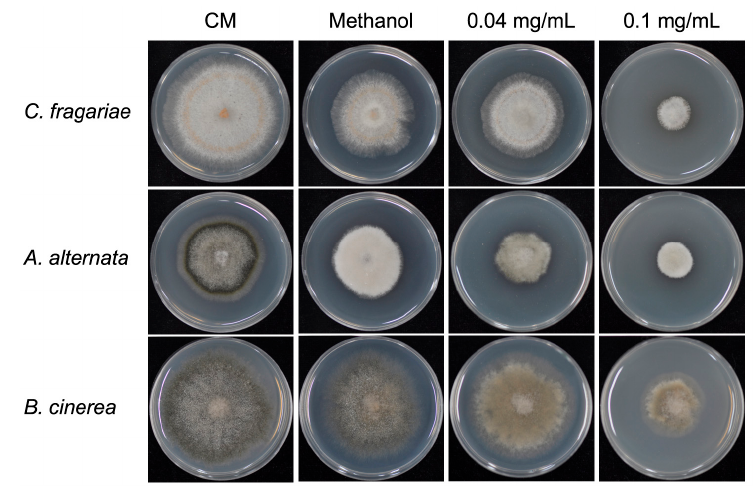
Figure 8. Inhibition test of equol to the mycelial growth of Colletotrichum fragariae , Alternaria alternata , and Botrytis cinerea . The strains were cultured on CM, CM supplemented with 0.04 and 0.1 mg/mL ( S )-equol, or with 2% methanol at 28 °C for 6 days on 6-cm culture plates.